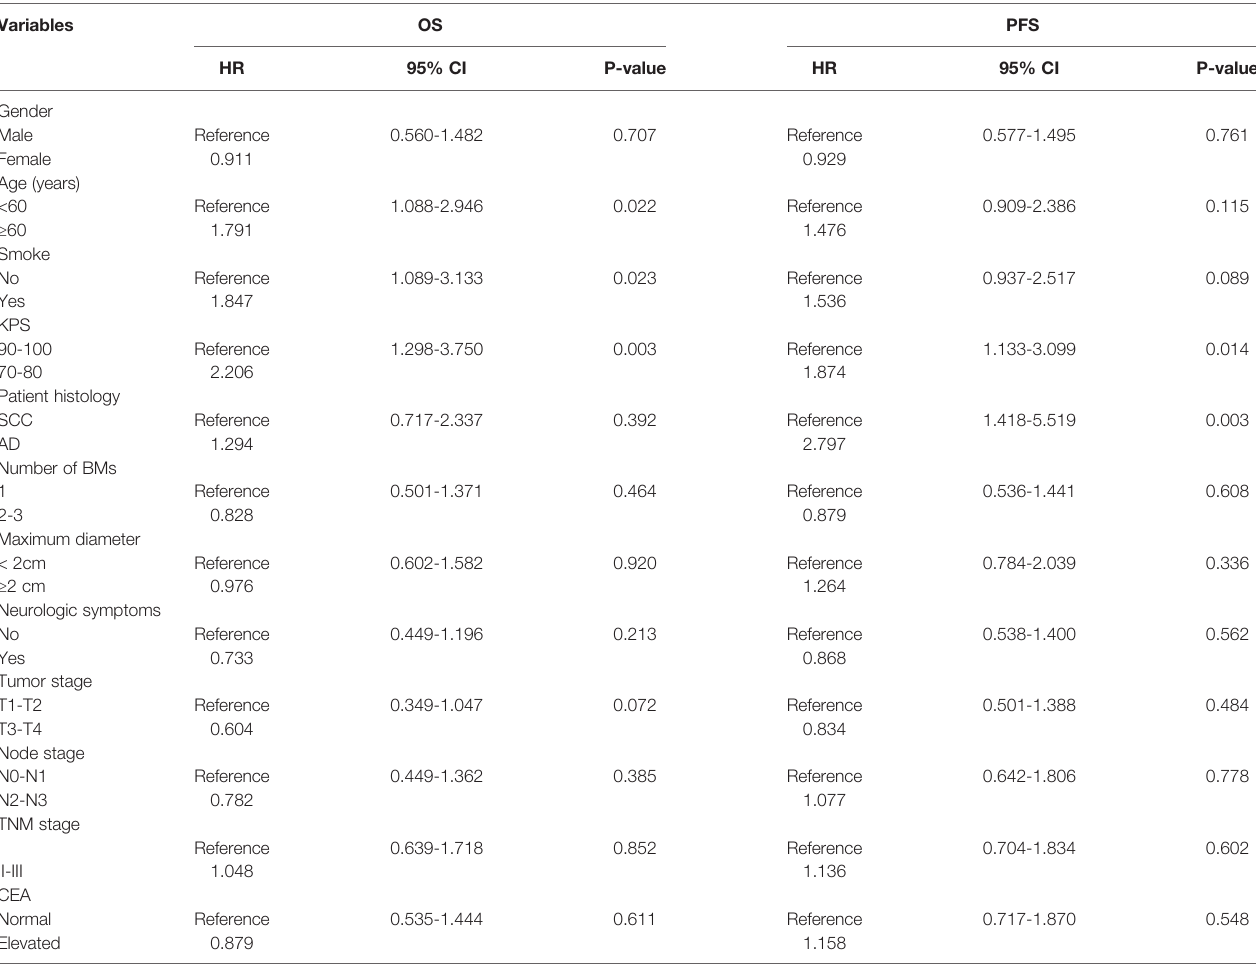
TABLE 3 | Univariate analysis of OS and PFS based on clinical-pathological data.